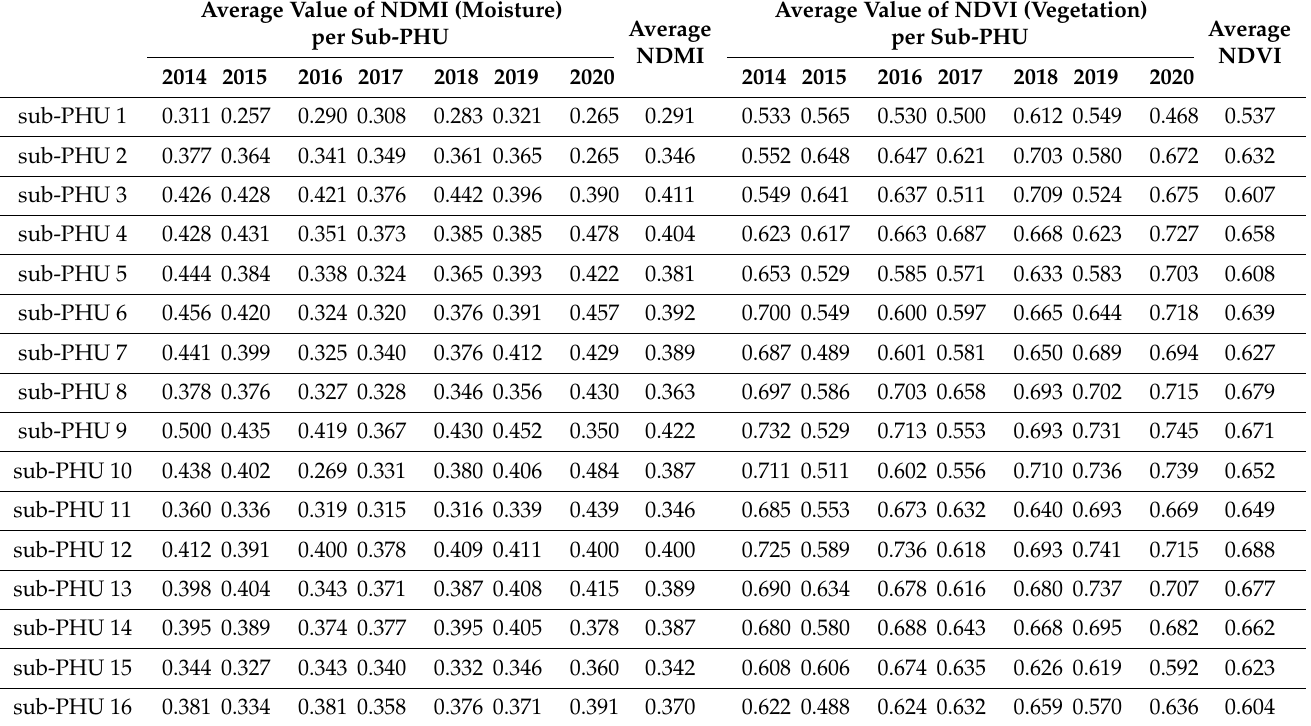
Table 4. Calculation result of average NDMI and NDVI values for each sub-PHU in 2010–2020 (data source: Landsat-8 using Google Earth Engine; processed by the